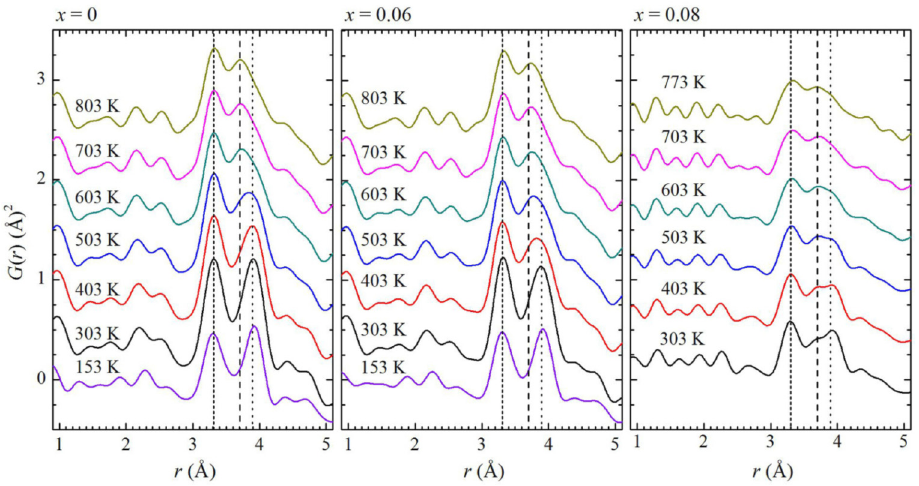
Figure 5. Temperature ‐ dependent X ‐ ray PDF patterns of BNBT for x = 0, 0.06, and 0.08. The short ‐ dashed lines (3.3 Å) mark the feature corresponding to A ‐ B distances; the dashed (3.7 Å) and dotted lines (3.9 Å) mark the two components in the feature related to A ‐ A and B ‐ B distances. Reproduced with permission from [39].